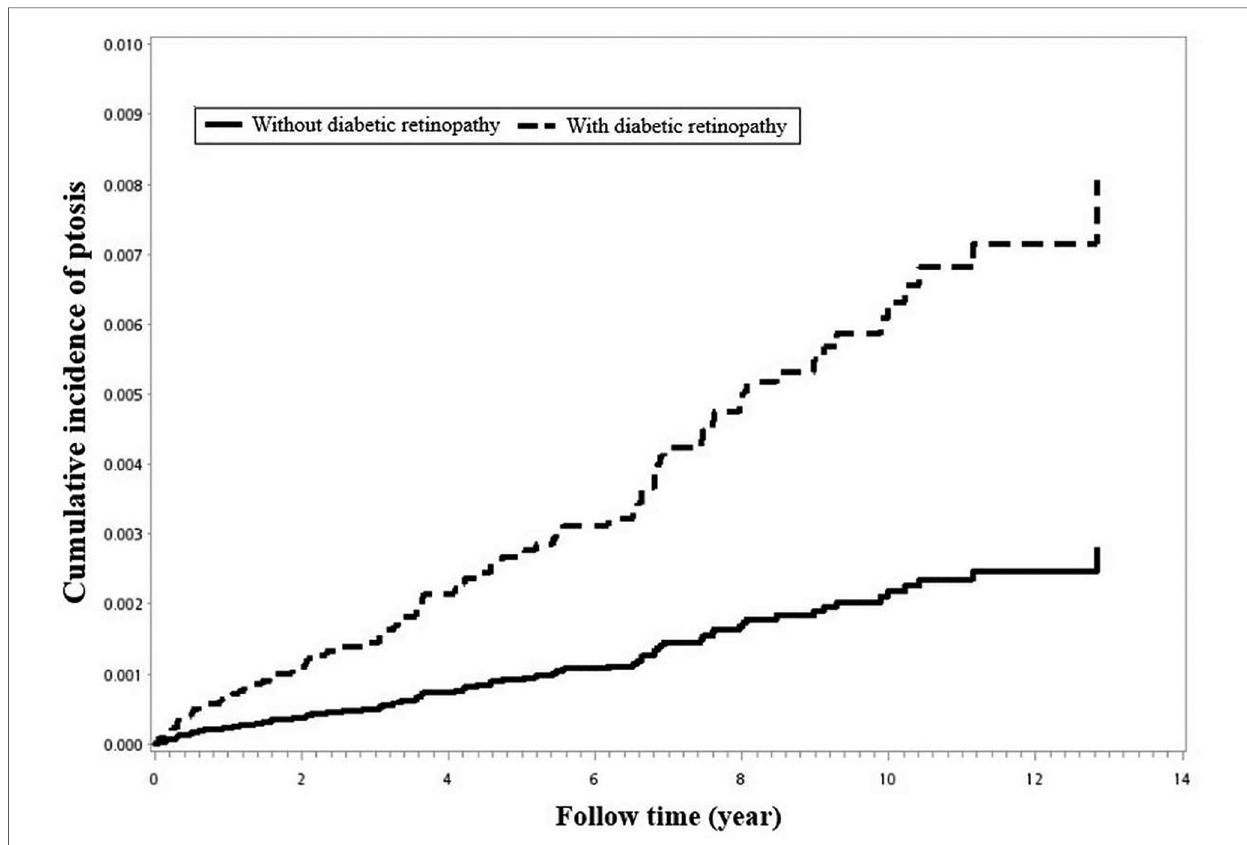
FIGURE 2 Using Kaplan – Meier survival statistics, it showed adjusted confounding factors survival curves by with and without diabetic retinopathy. (log-rank p